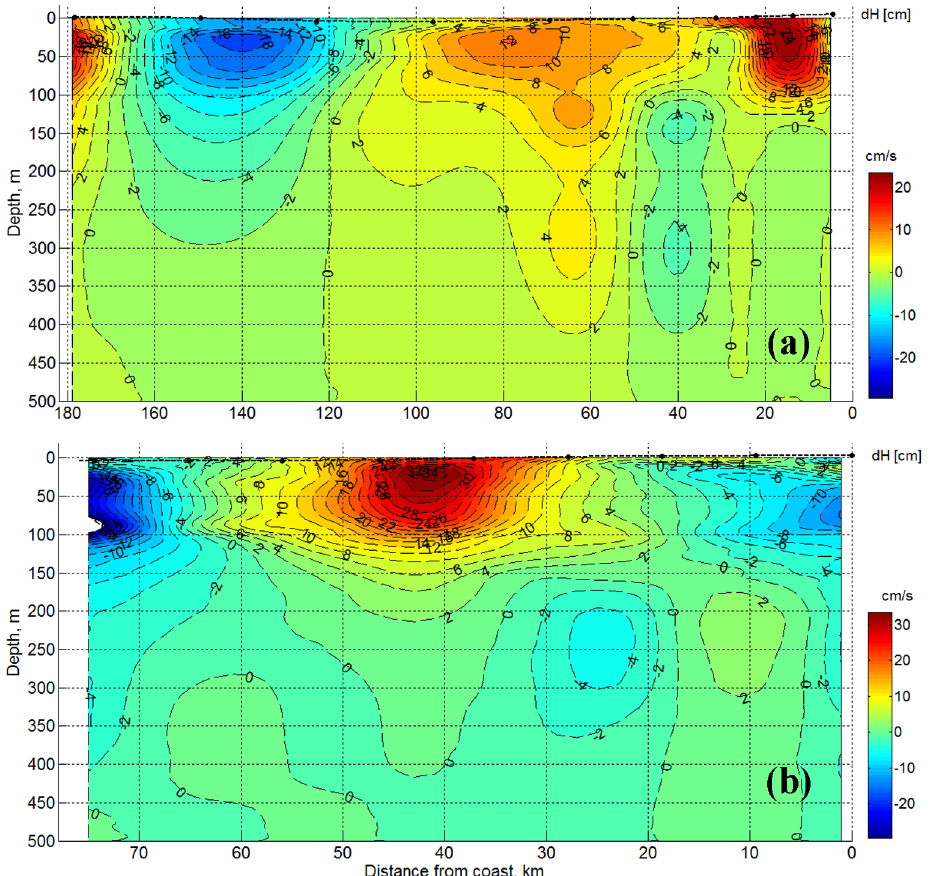
Figure 9. Alongshore velocity component near the Black Sea Gelendzhik test site of IO RAS calculated by the dynamic method on the base of R/V Akvanavt CTD measurements in ( a ) July 1998 and ( b ) June 2004. Blue color corresponds to the southeastern current, and dH is the sea surface